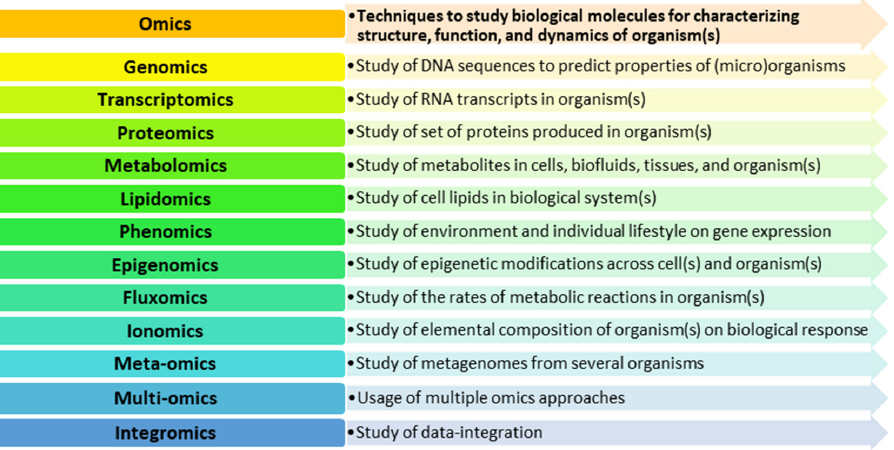
Figure 1. Omics methods with potential application in environmental research.